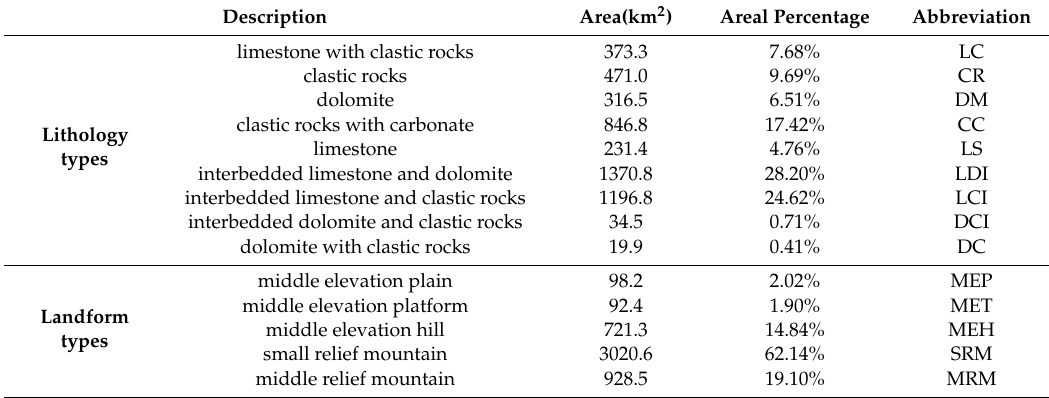
Table 1. Proportion of di ff erent lithology and landform types in the study area.